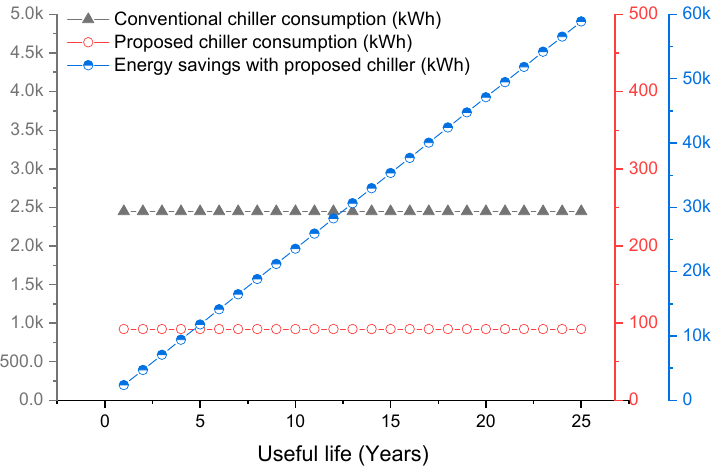
Figure 12. Energy savings caused by the proposed system.